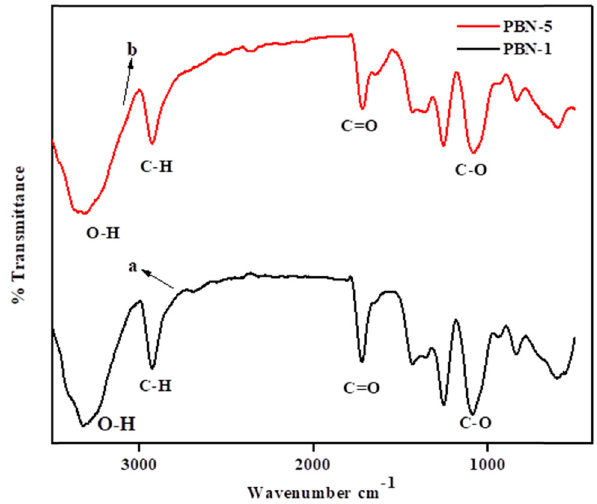
Figure 3: FT - IR spectra of MMT - reinforced nano fi bers only and with 0.8 g of the